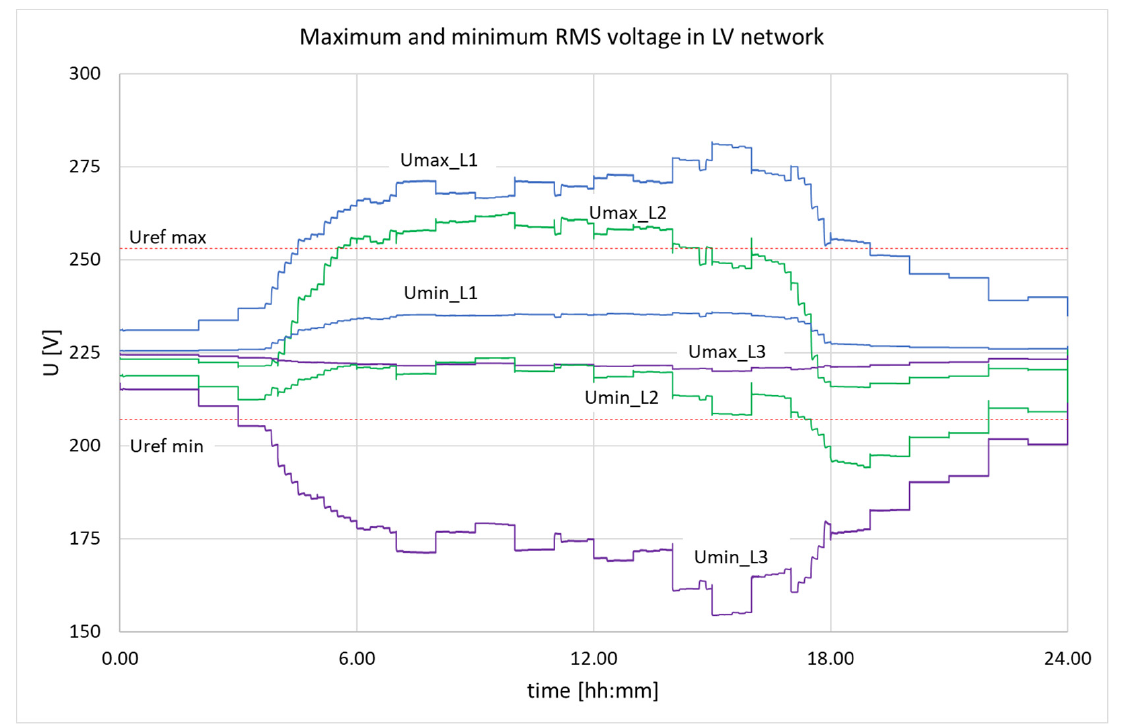
Figure 6. Maximum and minimum phase voltages in the network for one-day simulation period, reference case.